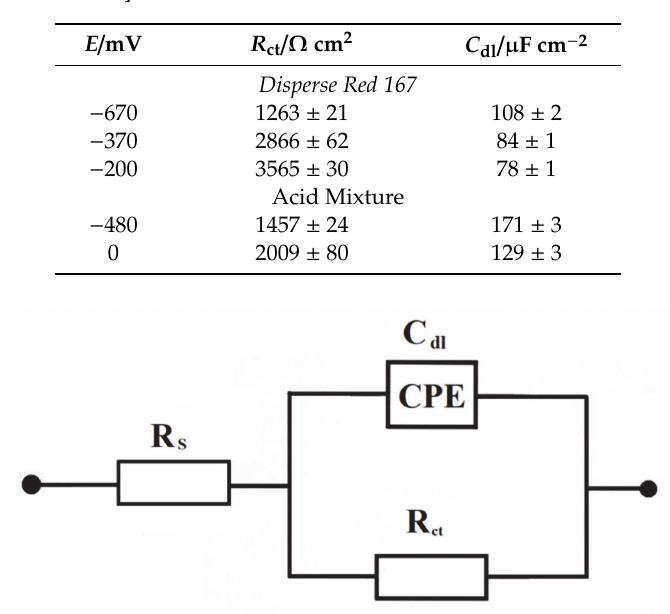
Figure 5. Equivalent circuit model used in a.c. impedance data modeling for the process of electrooxidation of azo dyes on the surface of Al alloy anode in Na 2 SO 4 supporting solution. The circuit contains a double-layer capacitance, C dl (as CPE: Constant Phase Element for distributed capacitance) and charge-transfer resistance, R ct , while R s is solution